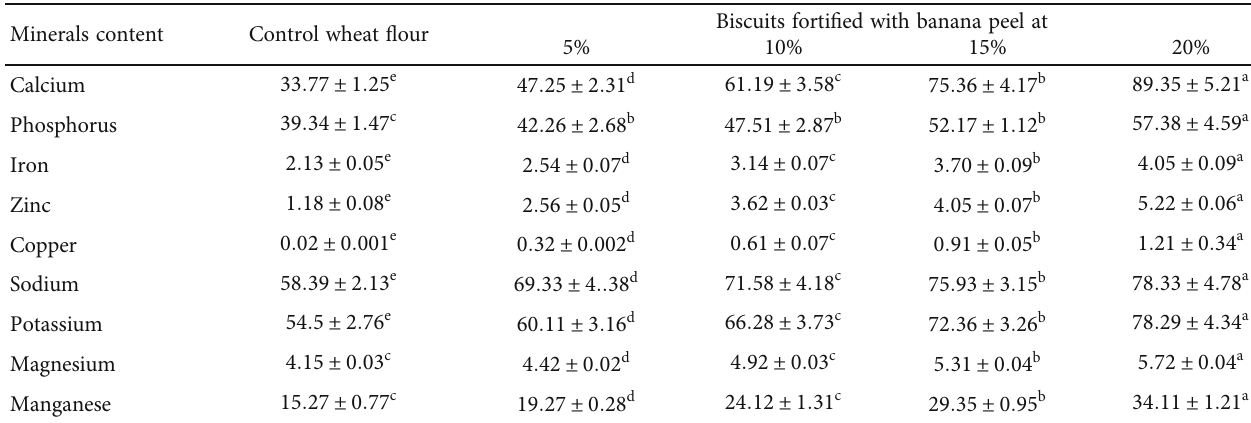
Table 3: Minerals content as mg/100g of biscuits on dry